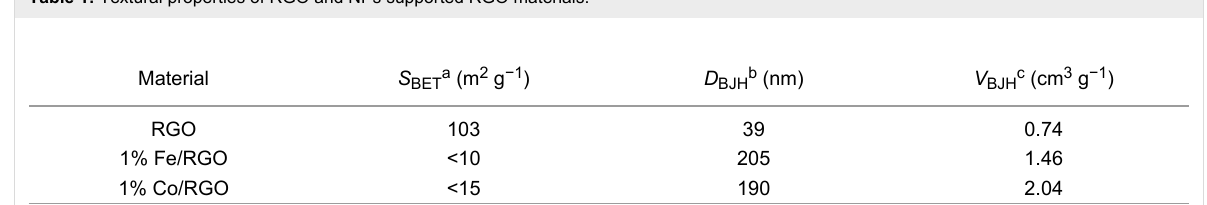
Table 1: Textural properties of RGO and NPs supported RGO